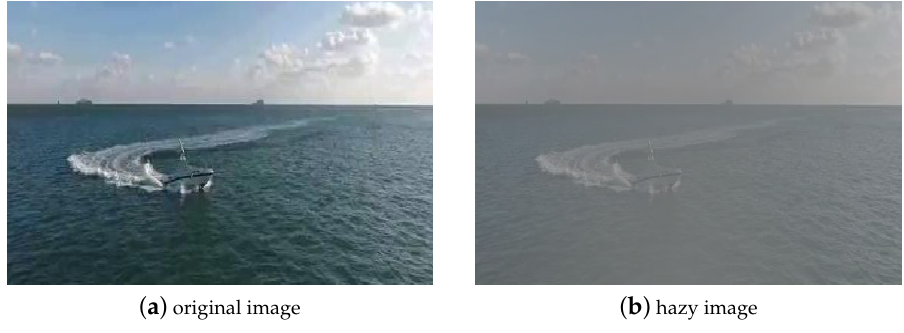
Figure 6. Experimental dataset examples in the